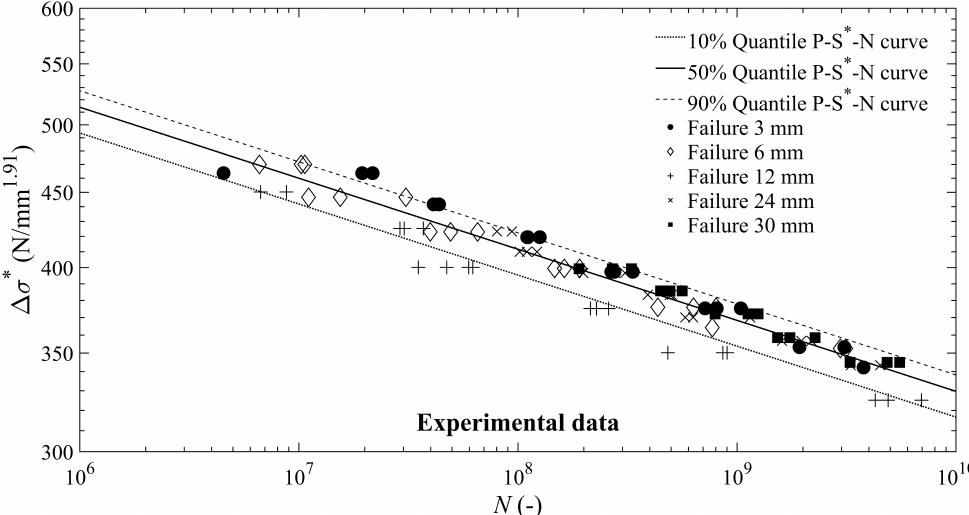
Figure 4. Estimated specimen-size independent probabilistic fractal stress-life curves against the experimental